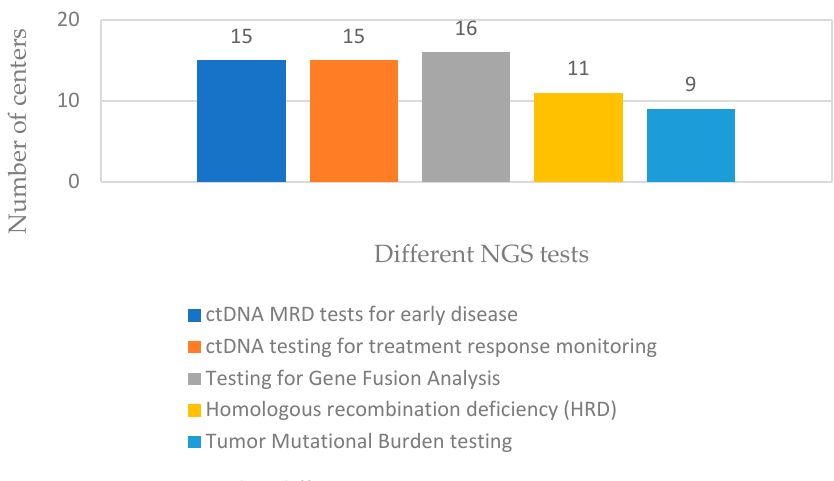
Figure 9. NGS tests used in different centres.